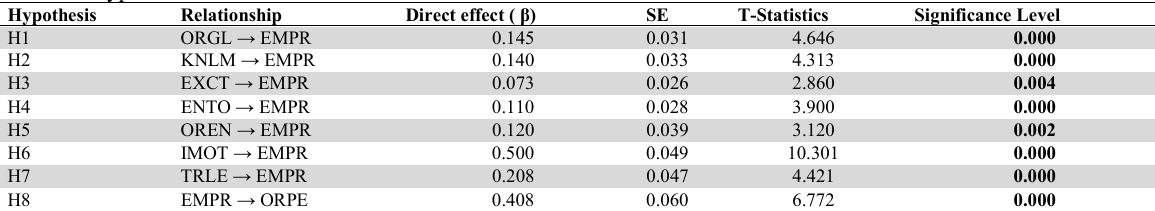
Results of hypothesis